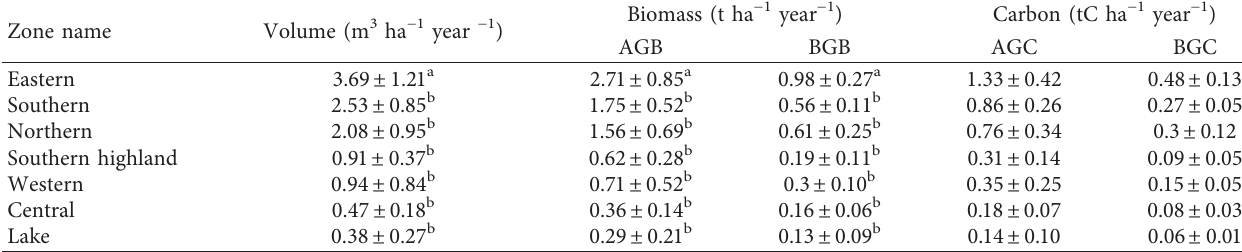
Table 3: Volume, biomass, and carbon removals in Miombo woodlands by zones in Mainland